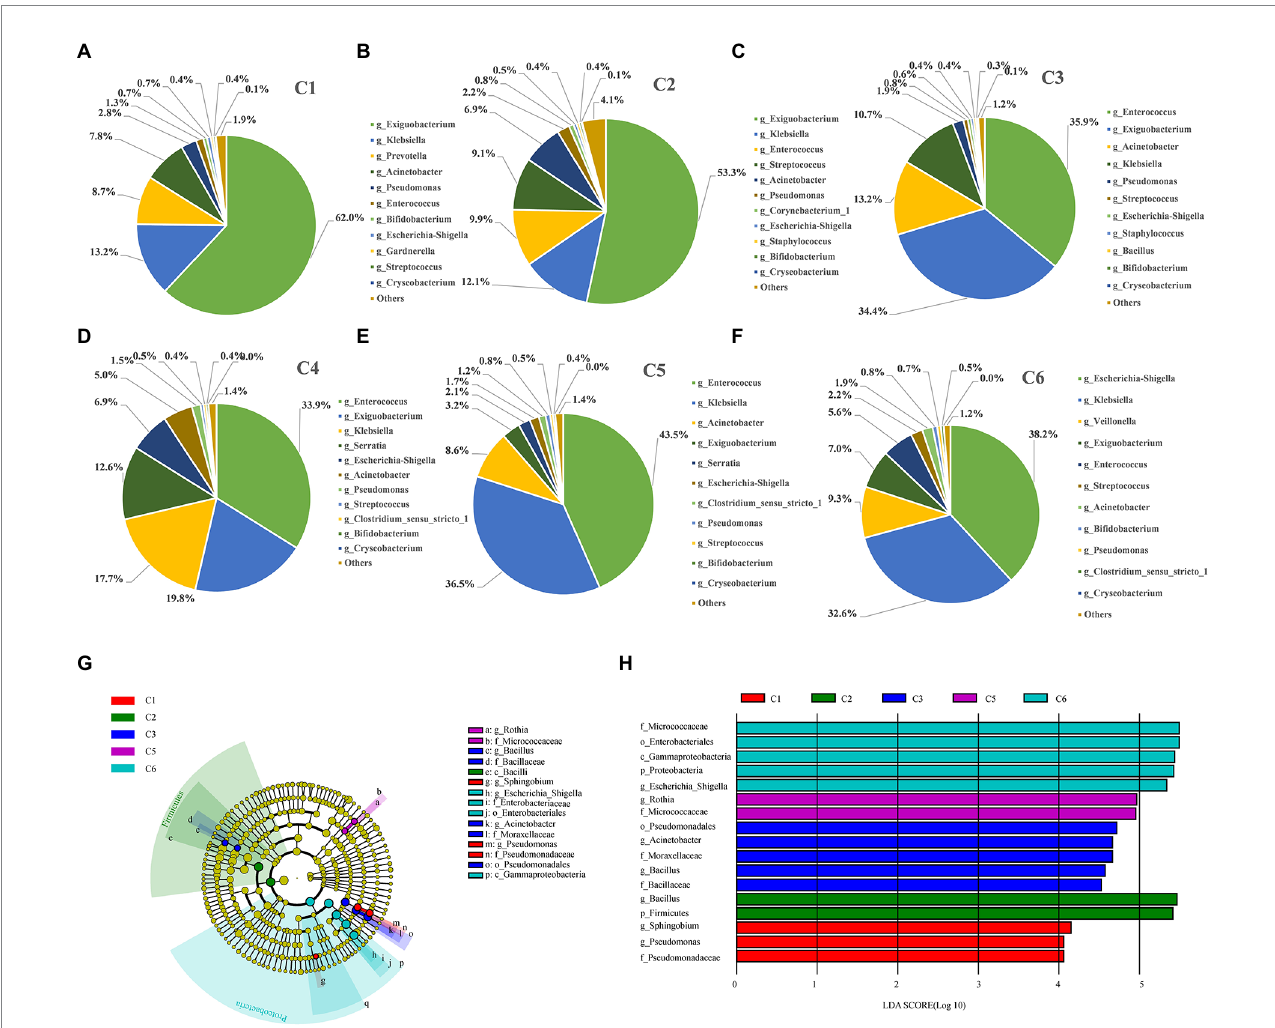
FIGURE 4 Figure Differentially abundant taxa enriched in the six time point groups of preterm infants. (A–F) Dynamic changes of dominant microbes at genus level in the intestinal tract of preterm infants at different time points. (G) Phylogenetic cladogram showing differentially abundant taxa from phylum to genus levels. Microbial classes are indicated with letters. Each node represents one taxon at different taxonomic levels. Node colors are the taxa that were observed with higher abundance in the relevant cohort (C1–C6). (H) Species with a significant difference have an LDA score greater than the estimated value; the default score is 2.5. The length of the histogram represents the LDA score; i.e., the degree of influence of species with significant differences between different